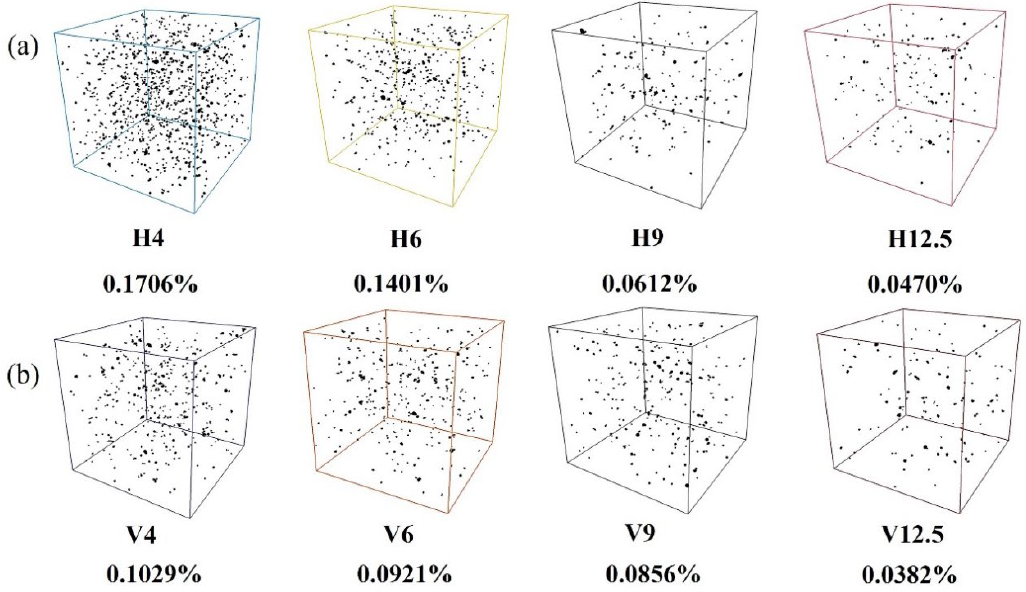
Figure 2. XCT reconstructions (500 px × 500 px × 500 px) and void density of the samples manufac- tured in ( a ) horizontal and ( b ) vertical